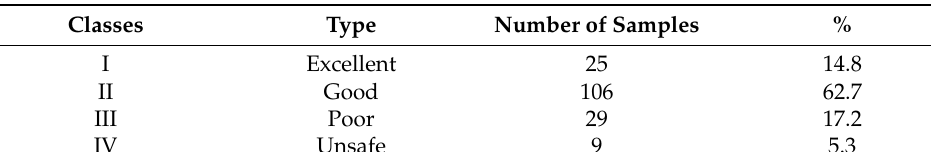
Table 4. Summary of WQI evaluation in the Wilaya of Na â ma.